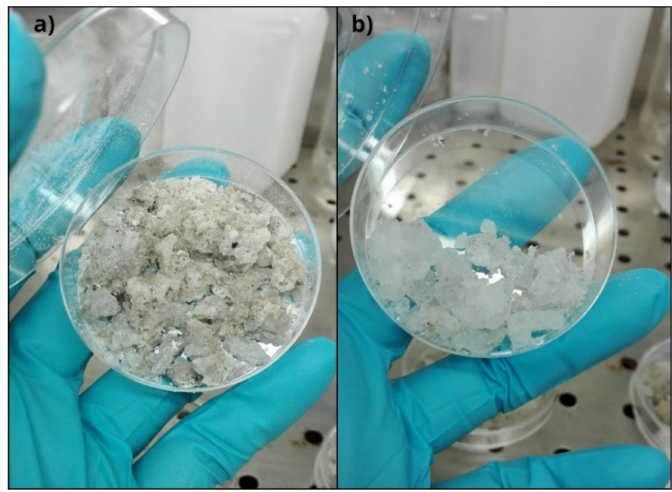
Figure 2. Salt samples analyzed in this study. ( a ) Dark salt (DS); ( b ) White salt